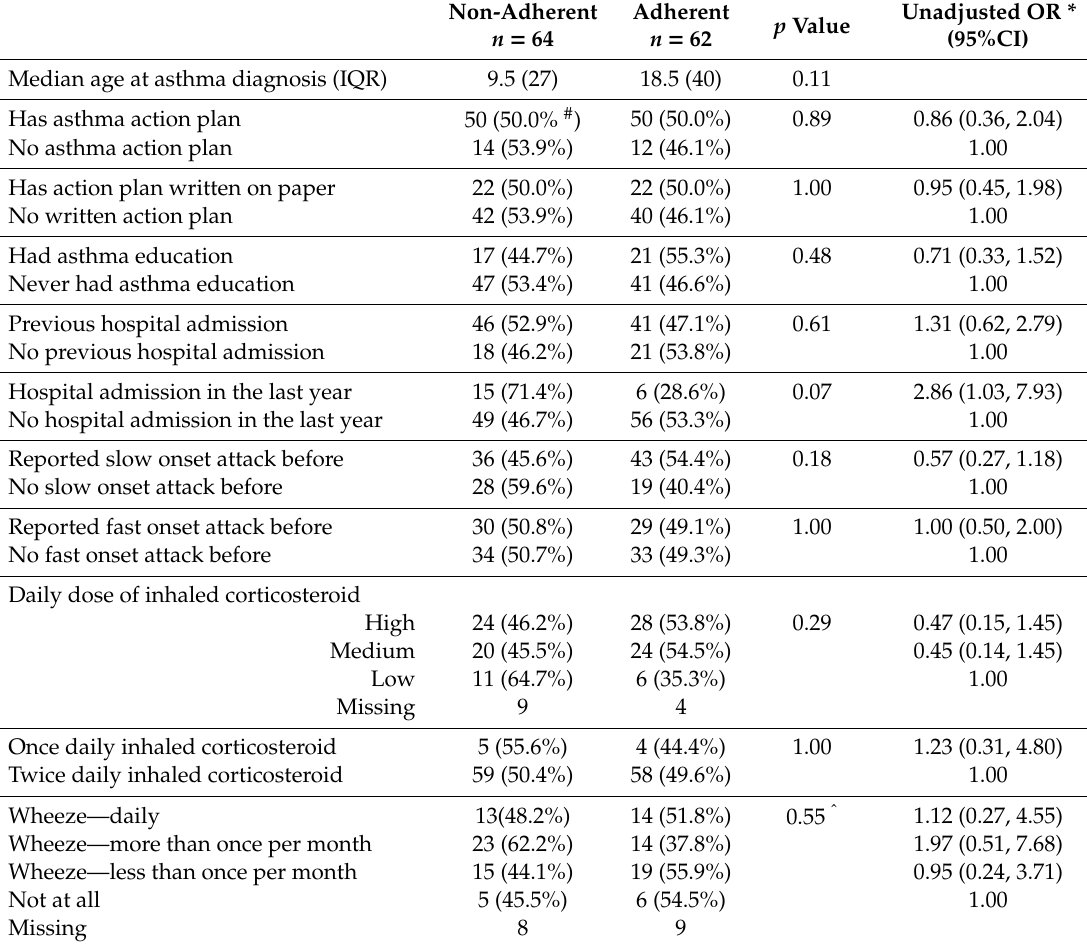
Table 3. Percentage of group non-adherent and adherent and risk of asthma characteristics.